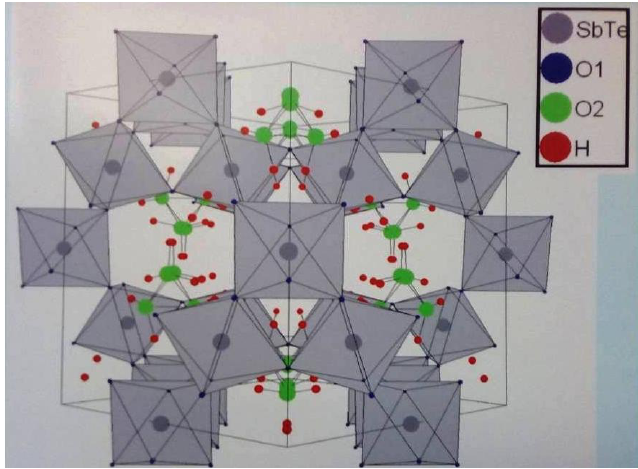
Figure 6. Crystal structure of proton conductor H 3 OSbTeO 6